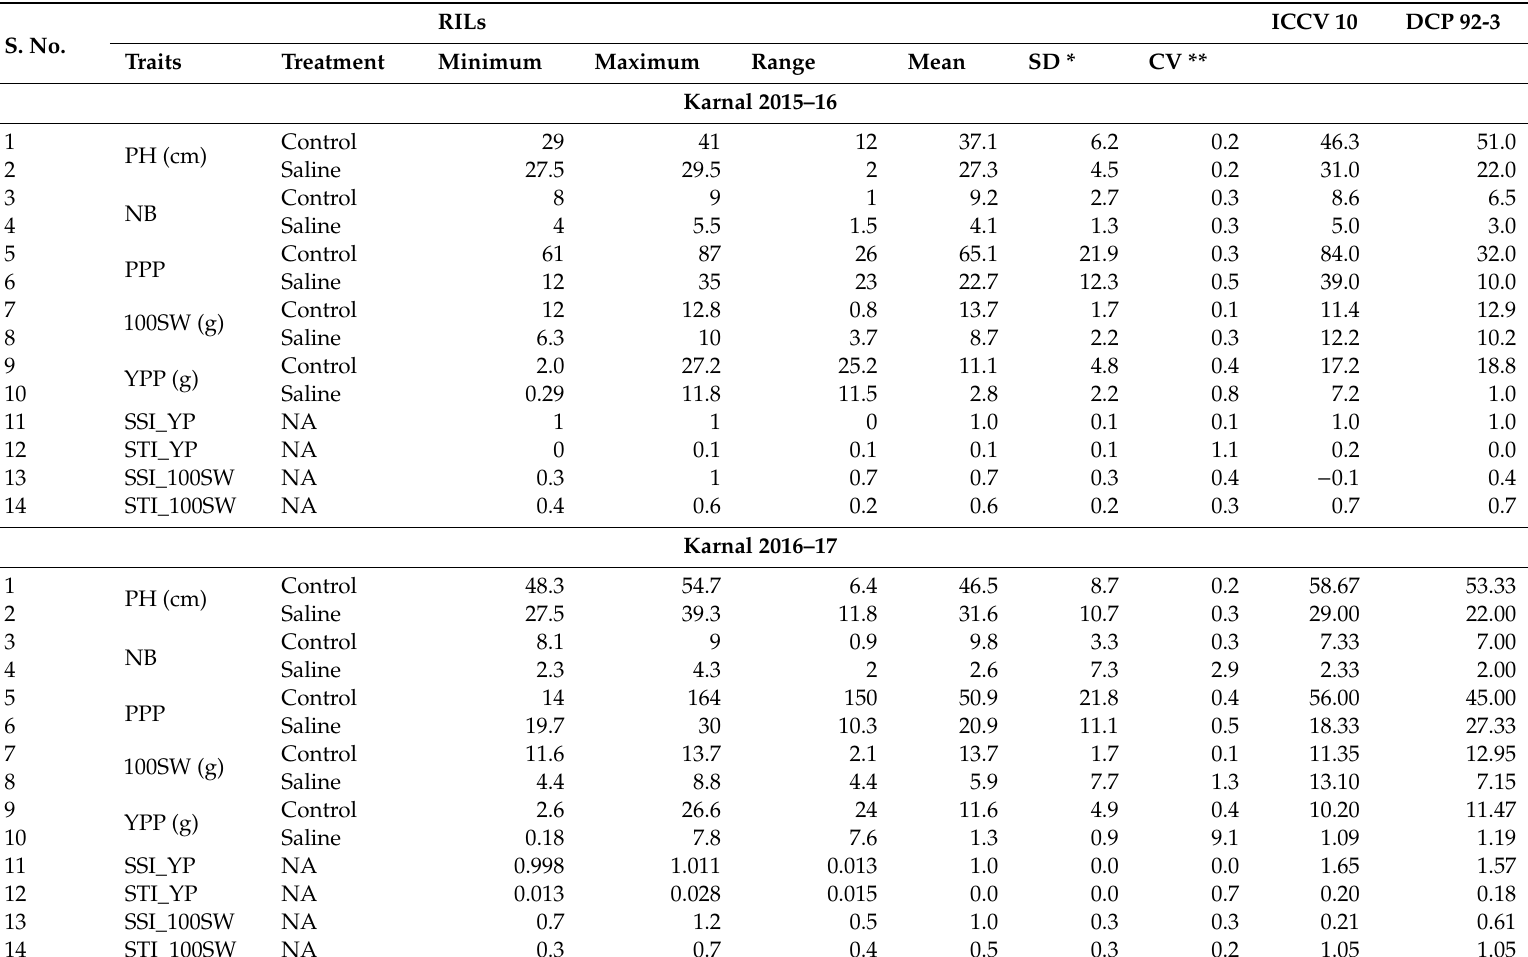
Table 1. Phenotypic variation for the parameters evaluated in the control and salinity treatments in the ICCV 10 × DCP 92-3 RIL population. S.